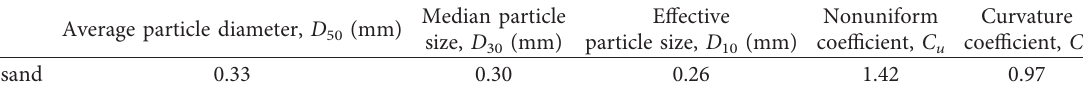
Table 1: Physical property indices of Tengger Desert sand.